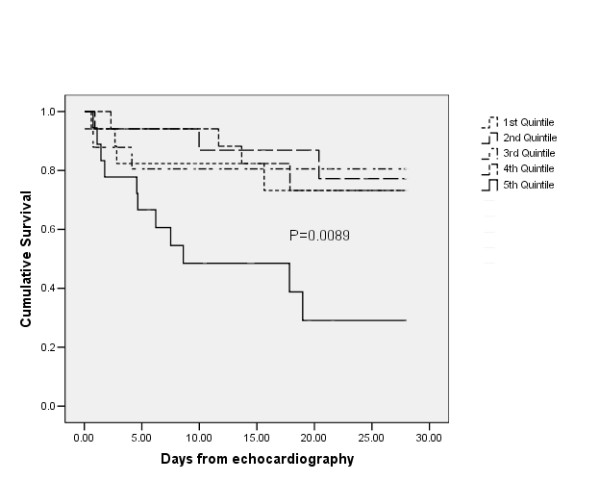
Survival at 28 days. Shown is a Kaplan-Meier curve of 28-day survival, according to quintiles of left ventricular end systolic volume (P = 0.0089). Threshold values (ml): first quintile ≤ 27; second quintile > 27 but ≤ 45; third quintile > 45 but ≤ 72; fourth quintile > 72 but ≤ 105; and fifth quintile > 105. Log rank analysis confirms no significant difference between survival curves for the first to fourth quintiles (P = 0.97).